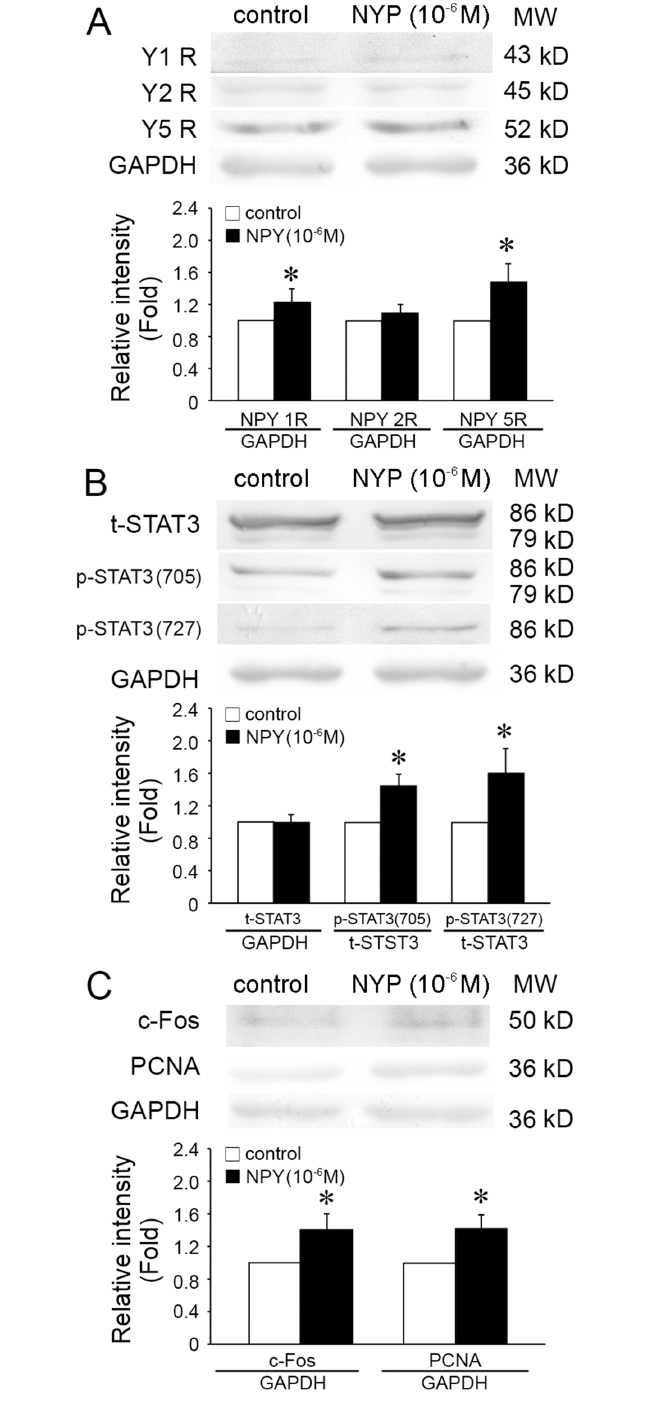
Fig 5. NPY modulated the expressions of NPY1R, NPY5R, phosphorylation of STAT3, and expression of c-Fos in cultured VSMCs. (A) After treatment of NPY for 24 hours, the expressions of NPY1R and NPY5R, but not NPY2R, were significantly increased in VSMCs (NPY2R, n = 4. NPY1R and NPY5R, n = 5). (B) After treatment of NPY for 24 hours, the phosphorylations of STAT3 at Tyr705 and Ser727 were both increased ( n = 6). (C) After treatment of NPY for 24 hours, the expressions of c-Fos and PCNA were significantly increased ( n = 4). Shown values are the mean ± SD , * P < 0.05 v . s . the respective control.